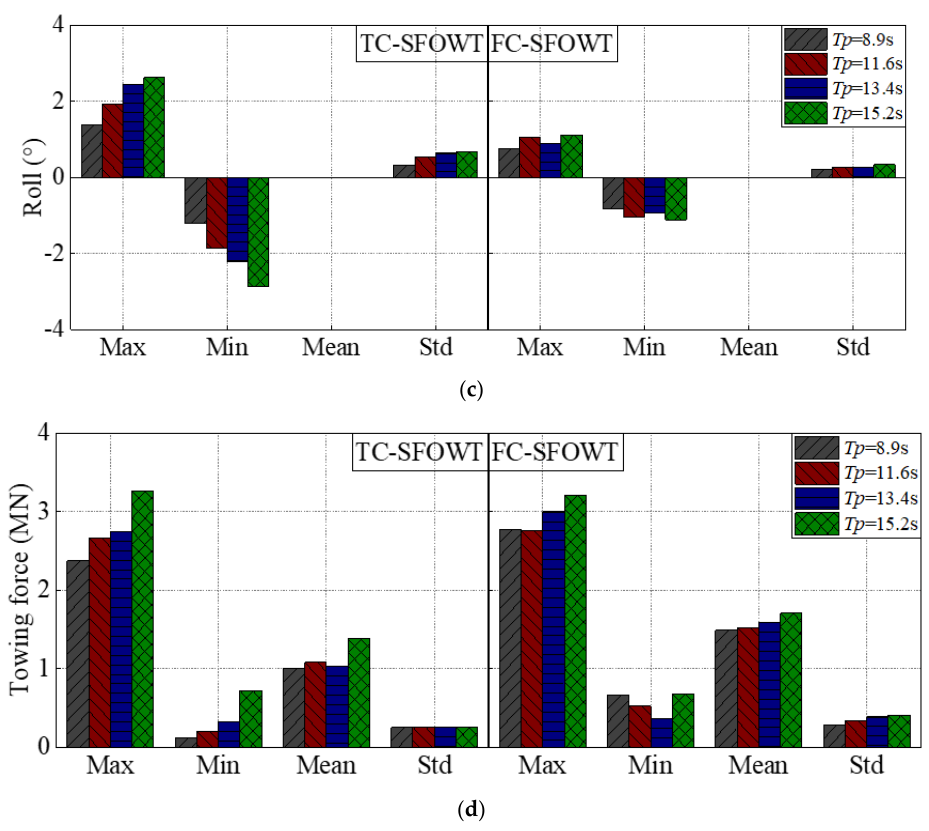
Figure 16. Statistics of the SFOWTs under different wave period conditions ( Hs = 5 m). ( a ) Heave motion, ( b ) pitch motion, ( c ) roll motion, ( d ) towing force.